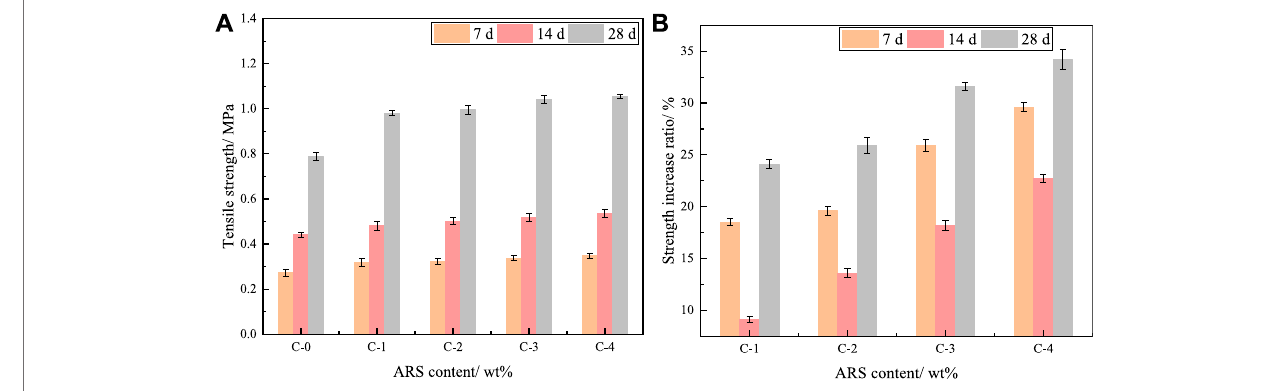
FIGURE 7 | The tensile strength of CTB and ARSCTB.